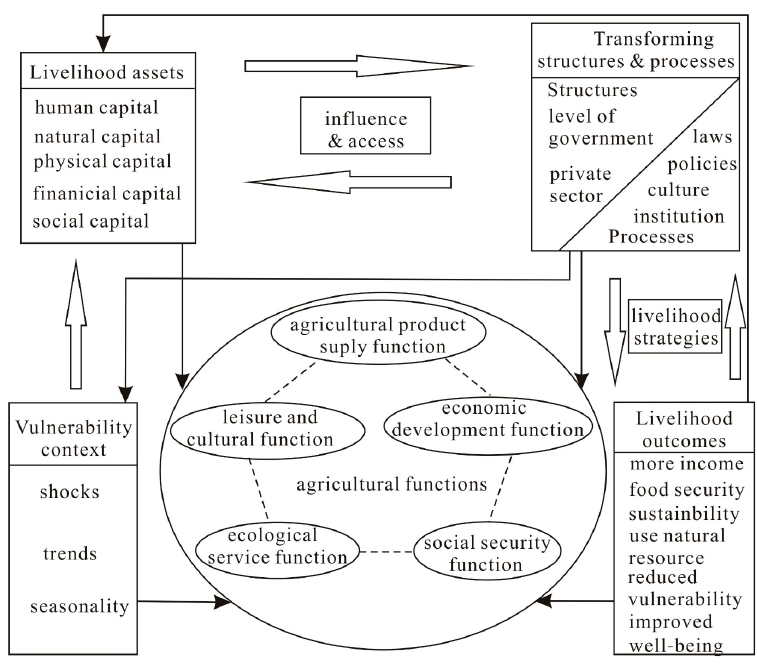
Figure 1. Framework of the interaction mechanism between household livelihoods and agricultural functions. Adapted from the UK Department for International Development (DFID) [60].